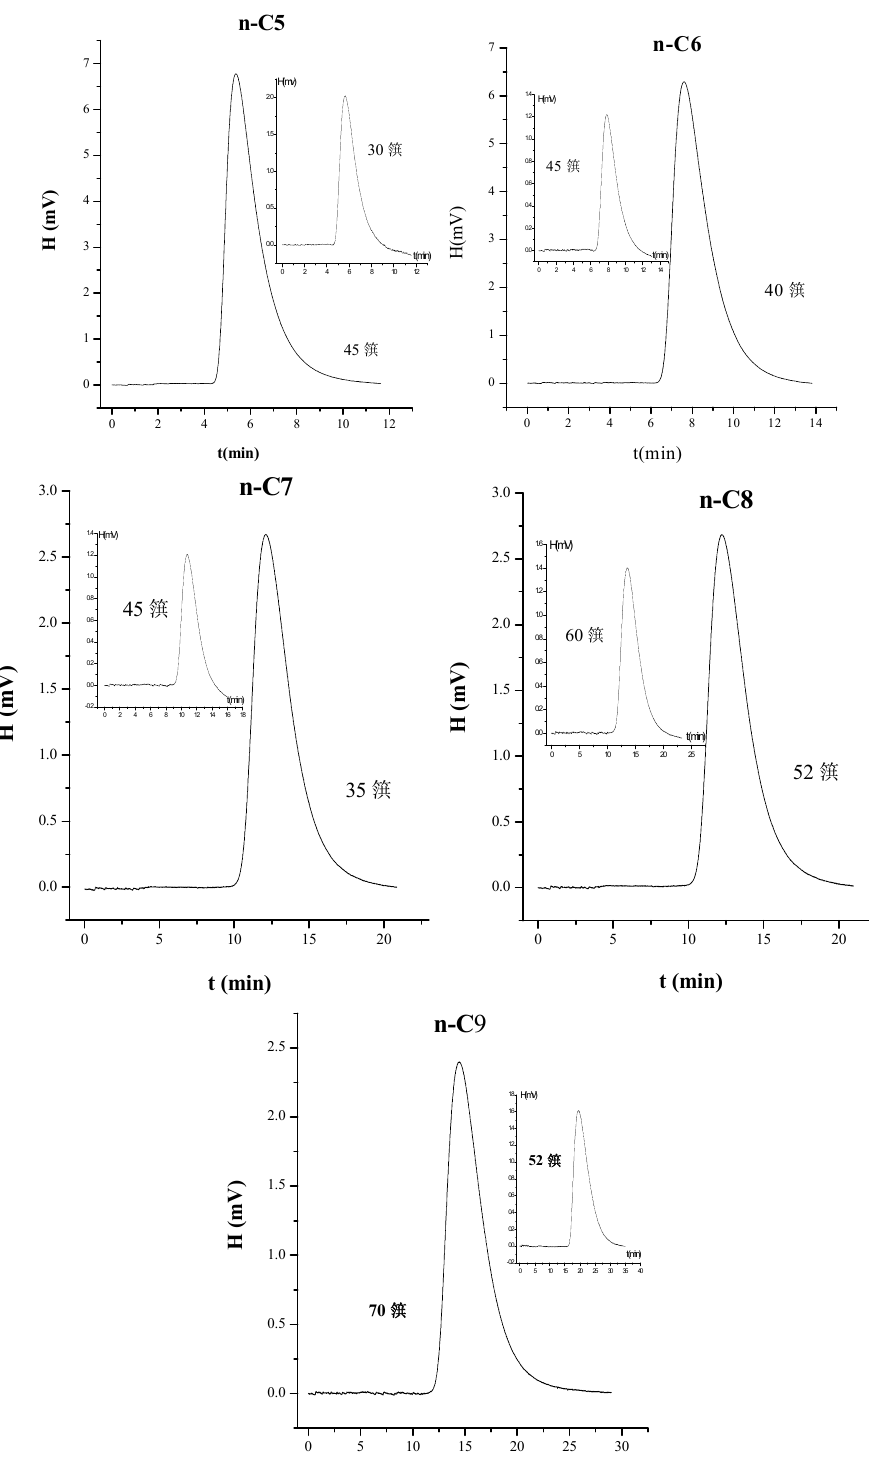
Figure 7. Chromatograms of n -C n in boehmite.